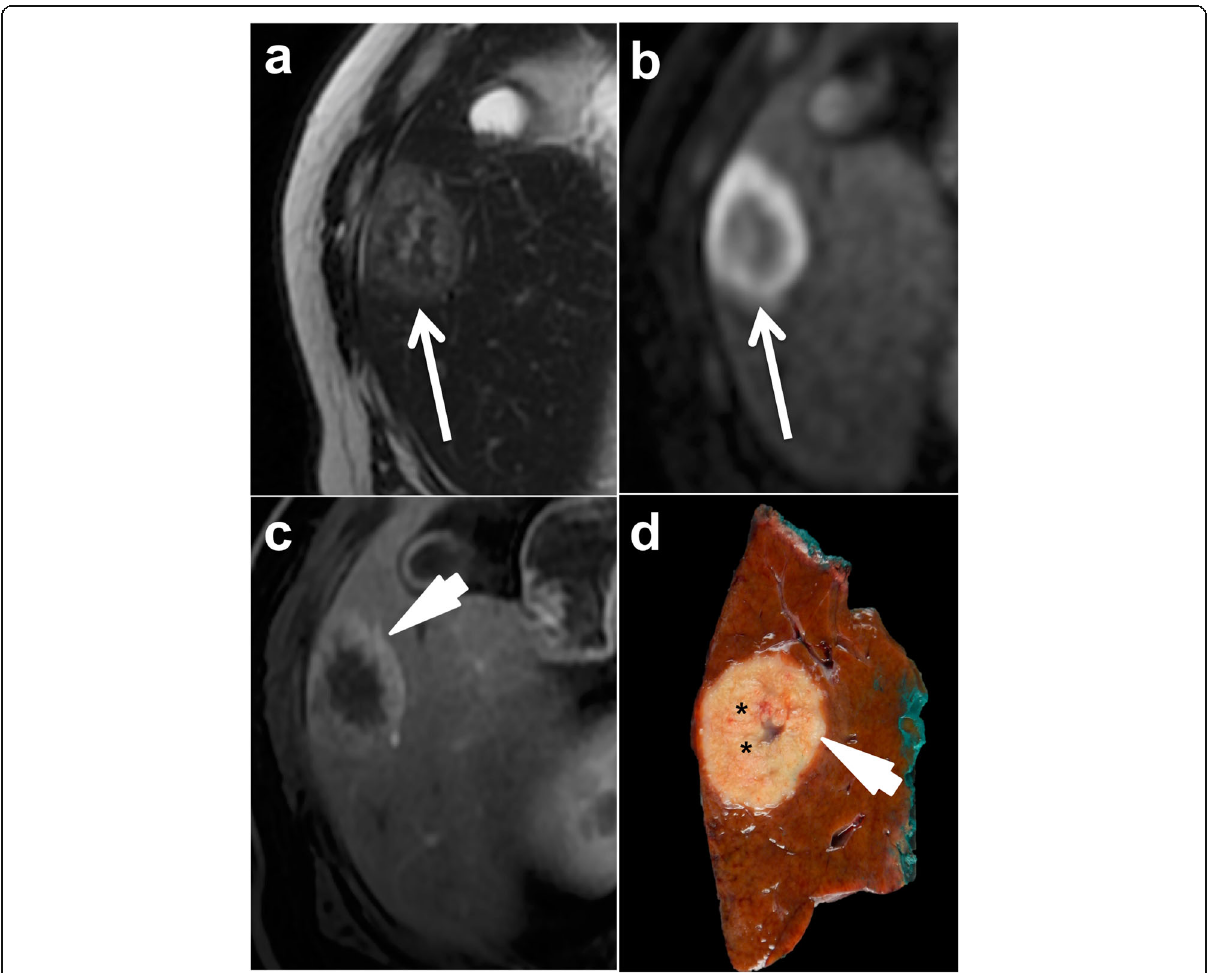
Fig. 4 Typical MR appearance of non-otherwise specific (NOS) adenocarcinoma liver metastases in a 55-year-old male patient with colon cancer. Fast spin echo T2-weighted image ( a ) shows a 50 mm lesion (arrow) in the right liver lobe with a mild hyperintense rim and a central heterogeneous area. On diffusion-weighted imaging ( b 600 s/mm 2 ) ( b ) the lesion has a peripheral hyperintense rim (arrow). The lesion also shows peripheral enhancement (arrowhead) on extracellular gadolinium chelate-enhanced fat-saturated gradient recall echo T1-weighted sequences obtained during the hepatic arterial phase ( c ). Gross pathology ( d ) confirmed the central necrosis of the lesion (black stars) and the predominantly peripheral tumor proliferation